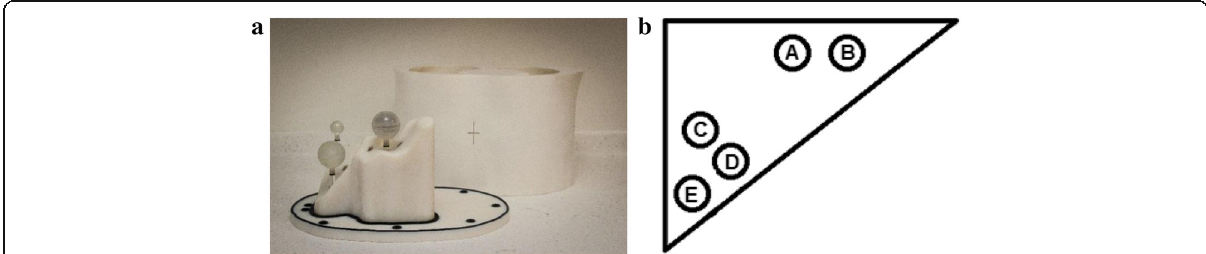
Fig. 1 a The AbdoMan ™ phantom, showing the fillable spheres mounted in the liver insert [19] . b Schematic representation of transaxial slice of AbdoMan ™ phantom showing positions of spheres (A = 20-mm sphere, B = 40-mm sphere with 25-mm solid core, C = 40-mm sphere, D = 10-mm sphere, E = 30-mm sphere) N.B. Spheres were not all located on the same slice, but are shown here on the same slice for